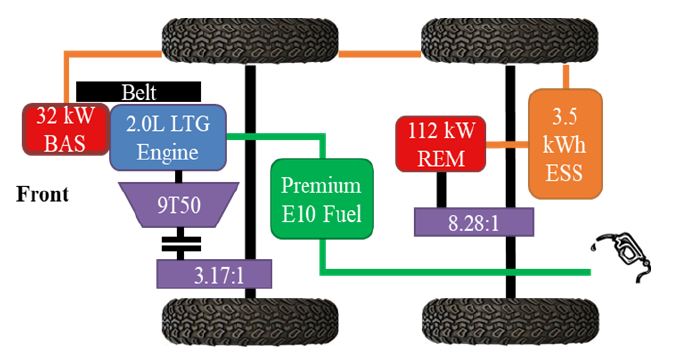
Figure 2. Vehicle